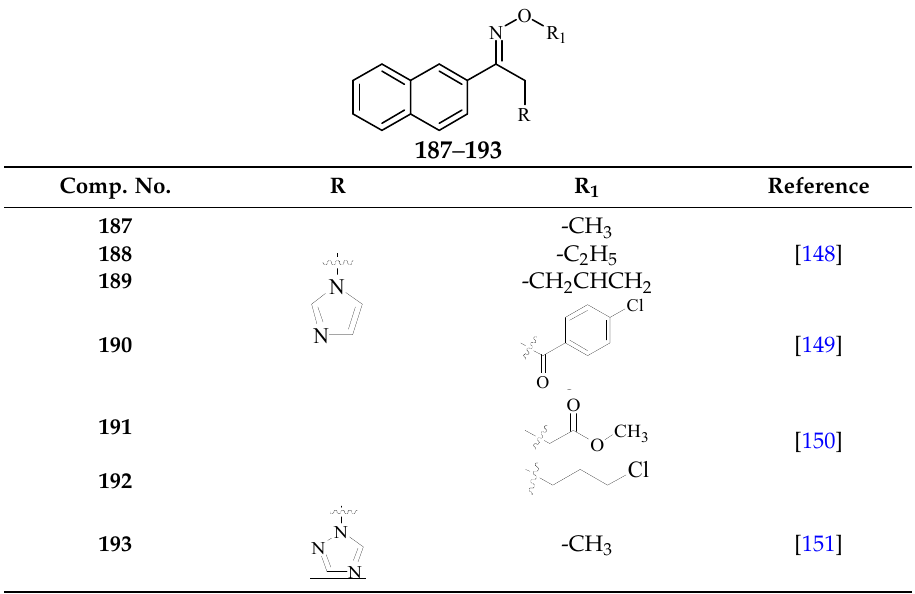
Table 9. Structures of compounds 187 – 193 .